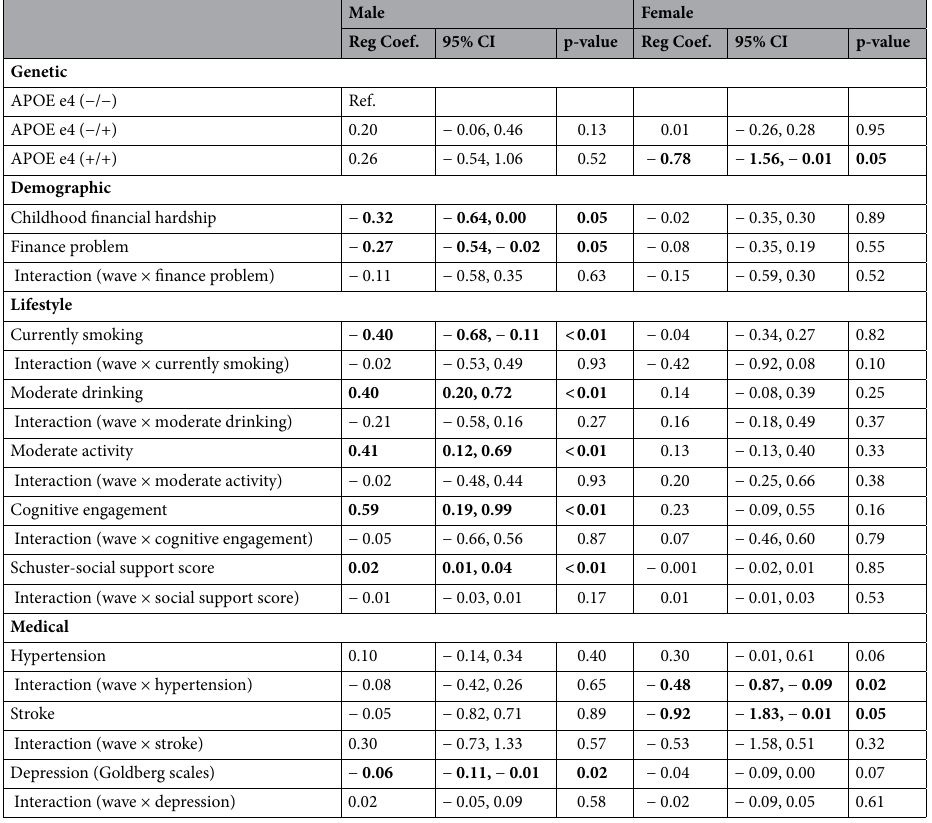
Table 2. Sex specific effects of risk factors on memory, and risk factor by wave interaction effects on memory decline (40 s cohort). Bold values indicate